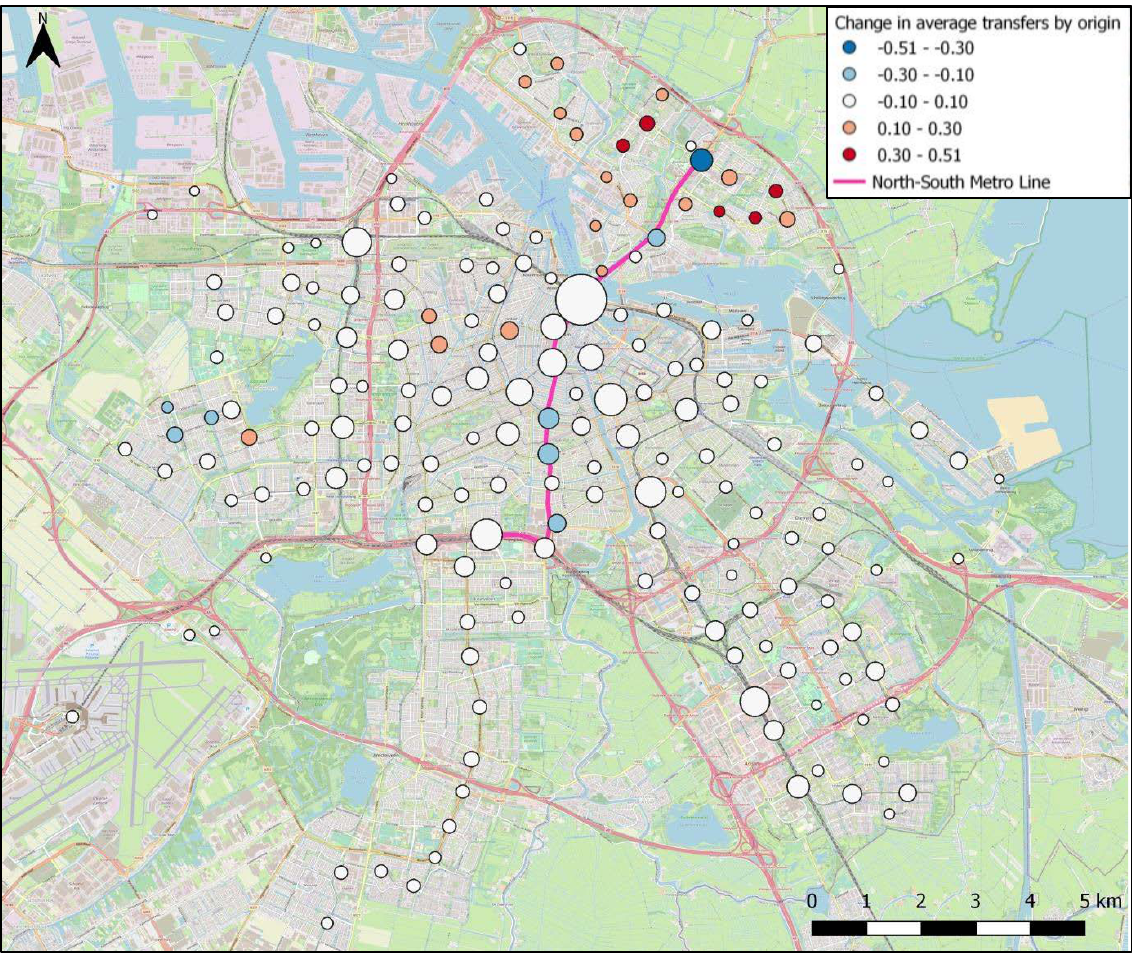
Figure 11. Geographical distribution of changes in number of transfers by origin stop cluster (weekday 7am to 7pm) (Base map and data from OpenStreetMap and OpenStreetMap